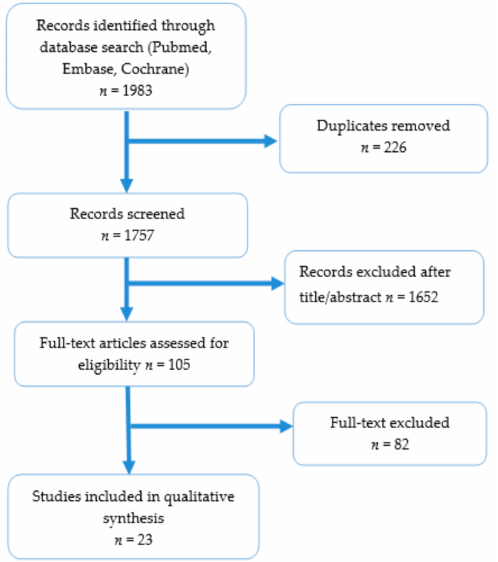
Figure 1. PRISMA search scheme; n = number of